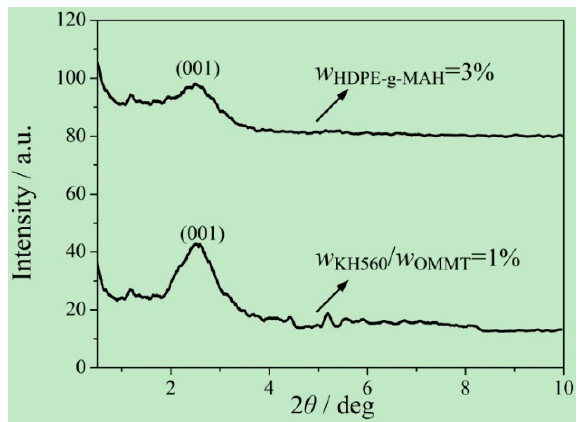
Figure 10. Thermal deformation temperature and Vicat softening temperature of OMMT-modified UHMWPE with an increasing amount of KH560. ( a ) Thermal deformation temperature, ( b ) Vicat softening temperature (repeated three times). Materials 2020 , 13 , x FOR PEER REVIEW